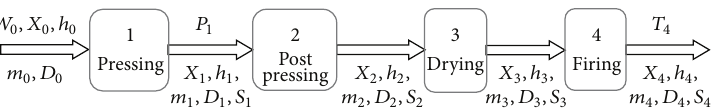
Figure 2: Flow diagram and variables of porcelain tile fabrication